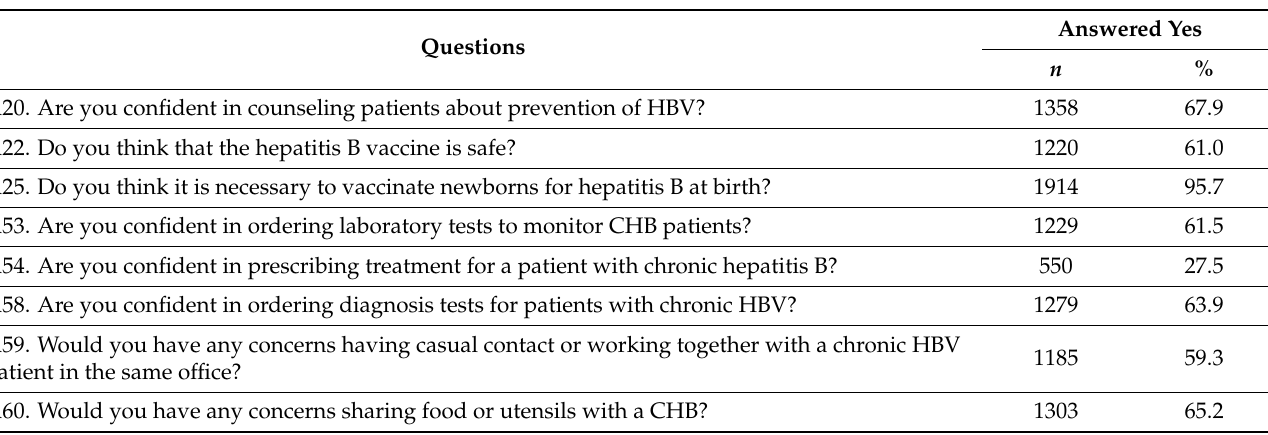
Table 3. Attitude about HBV ( n = 2000).